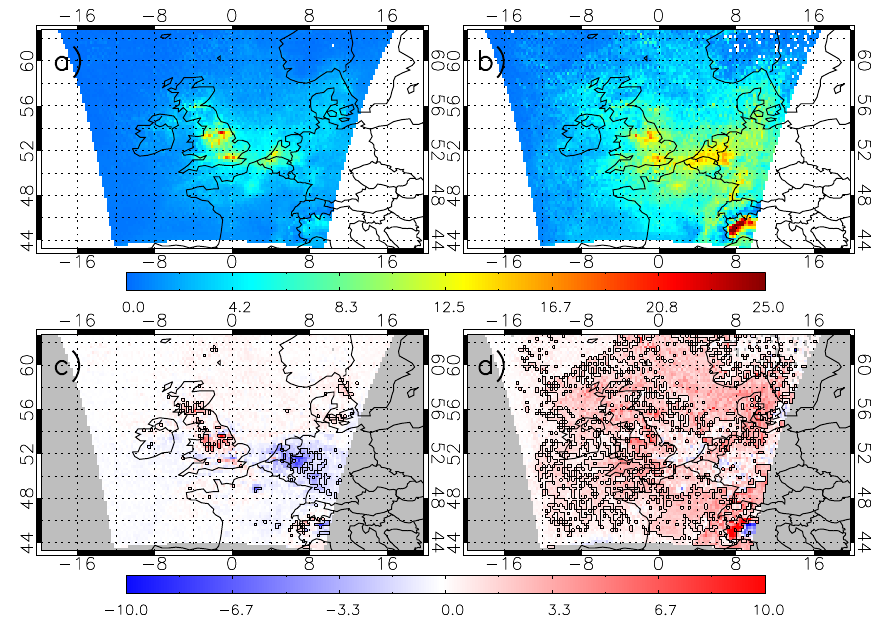
Figure 6. Tropospheric NO 2 column ( × 10 15 moleculescm − 2 ), 2006, from AQUM Run MACC (AKs applied) for (a) summer and (b) win- ter. AQUM Run MACC (AKs applied) and OMI mean bias for (c) summer (RMSE = 3.74 × 10 15 moleculescm − 2 and FGE = 0.63) and (d) winter (RMSE = 6.00 × 10 15 moleculescm − 2 and FGE =